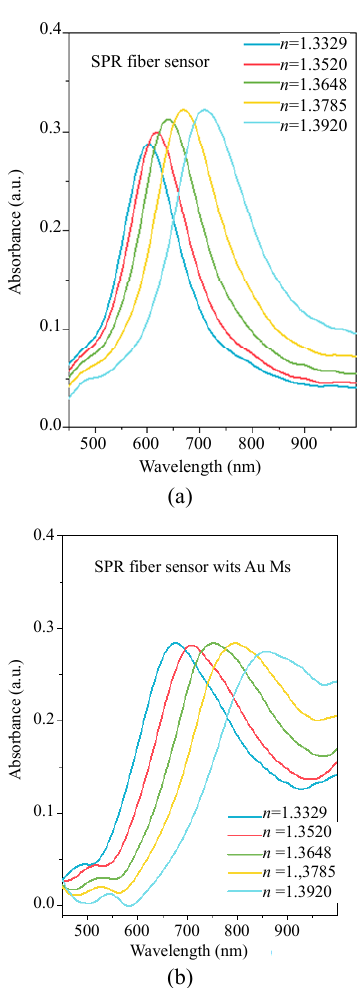
Fig. 5 Surface plasmon resonance peak as a function of refractive index of surrounding medium (water/glycerol ratio), measured on the: (a) simple SPR sensor and (b) hybrid SPR sensor with grafted AuMs nanoparticles.